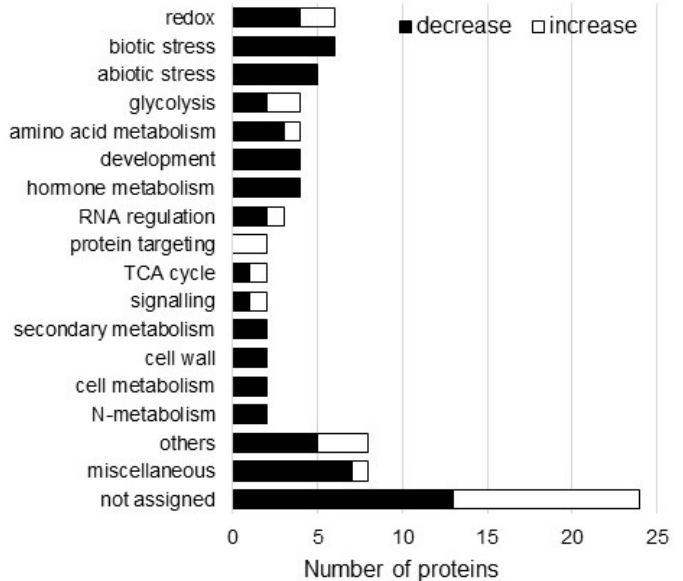
Figure 3. Functional categories of proteins with differential abundance in wheat root treated with AgNPs/nicotinate/KNO 3 . Three-day-old wheat seedlings were treated with and without the mixture of 5 ppm AgNPs, 8 mM nicotinate, and 0.1 mM KNO 3 for 3 days. Proteins extracted from the root were analyzed using a gel-free/label-free proteomic technique. The significantly changed proteins were identified ( p < 0.05) and functionally categorized using MapMan bin codes (Table S3). The x-axis indicates the number of identified proteins. White and black columns mean the number of increased and decreased proteins, respectively, proteins by treatment with 5 ppm AgNPs/8 mM nicotinate/0.1 mM KNO 3 compared with untreated plant. Abbreviation: TCA cycle, tricarboxylic acid cycle.